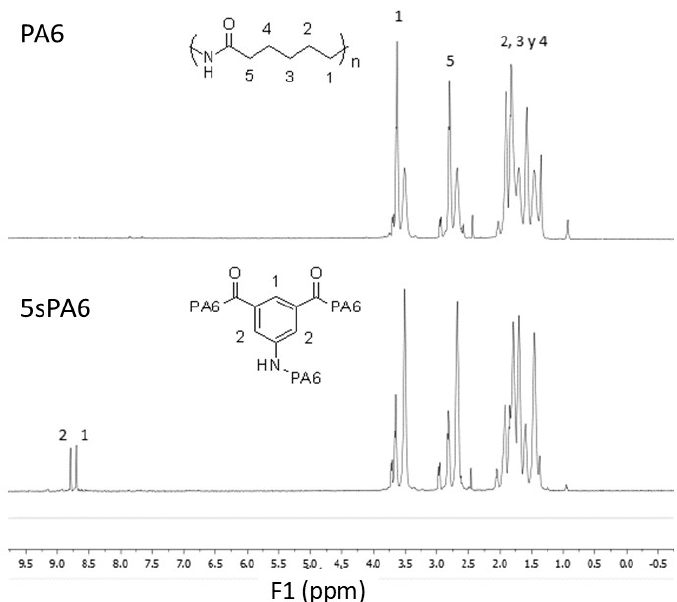
Figure 2. 1 H spectra of the raw PA6 and the star-branched polyamide 5sPA6. Wide-Angle X-ray Scattering (WAXD)